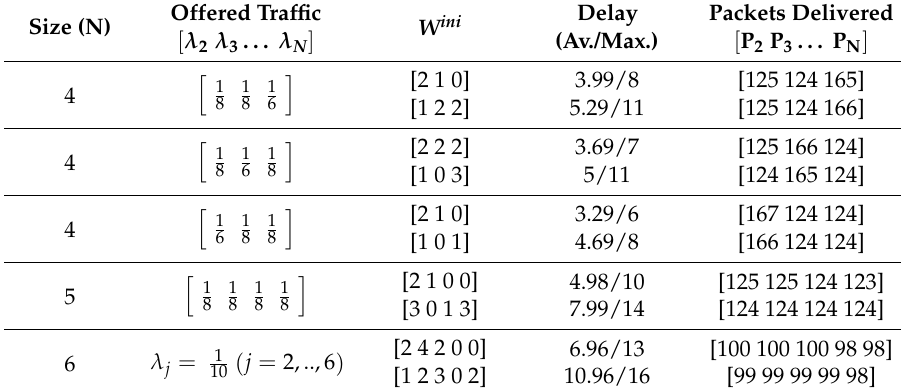
Table 3. Delay of the optimal scheduling (slots) using Round-Robin. Simulation time: 1000 time slots. Offered Size (N)